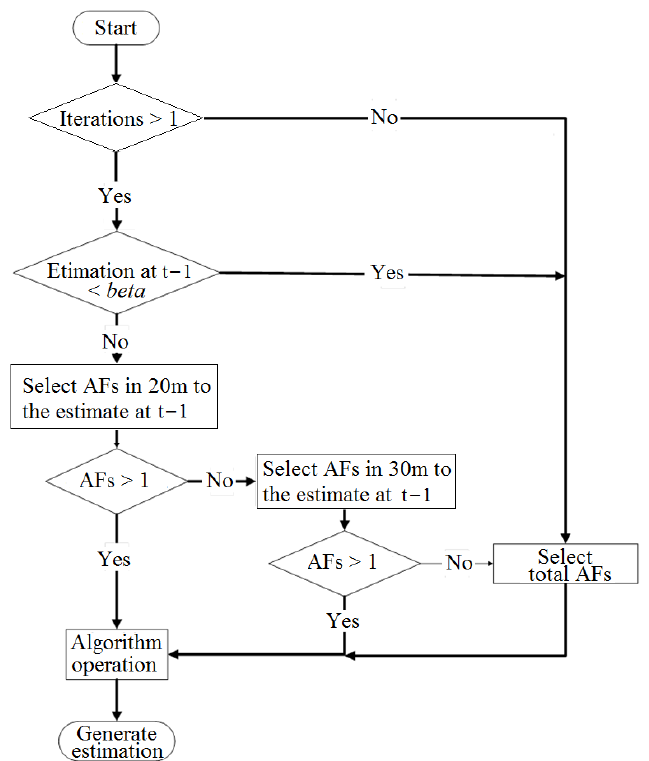
Figure 9. The procedure of DAFS method.